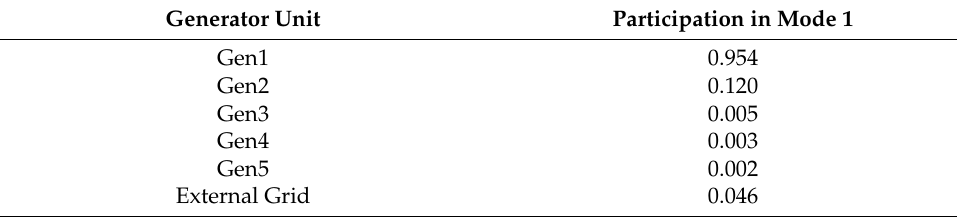
Table 2. Participation of the generator speed state variable for the dominant oscillatory mode.